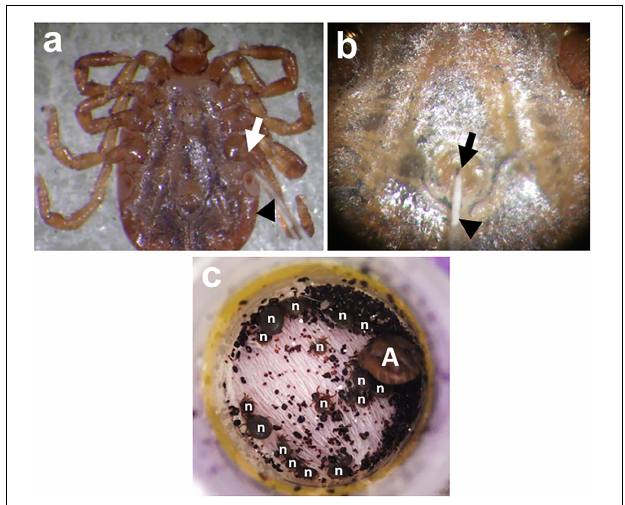
FIGURE 2 | Percoxal (a) and anal pore/rectal (b) injections to H. longicornis adult ticks. Infection is accomplished by injecting the virus inoculum containing an estimated virus titer using glass microneedles (black arrowheads) at the joint of the tick coxa and trochanter of the 4th pair of legs (white arrow) or into the tick’s anal aperture (black arrow). After injection, ticks will be kept for 24 h in a 25 ◦ C incubator to observe for any mortality arising from possible injury due to the injection. Co-feeding (c) between a THOV-infected H. longicornis adult (A) and smaller uninfected/naïve nymphs (n). The ticks were infested on mice using feeding chamber/capsule method. All engorged nymphs post infestation will be collected and allowed to molt. Twenty-one days after molting, newly emerged adult ticks will be examined for either the presence of infectious virions or viral RNA using a focus formation assay or real-time PCR,